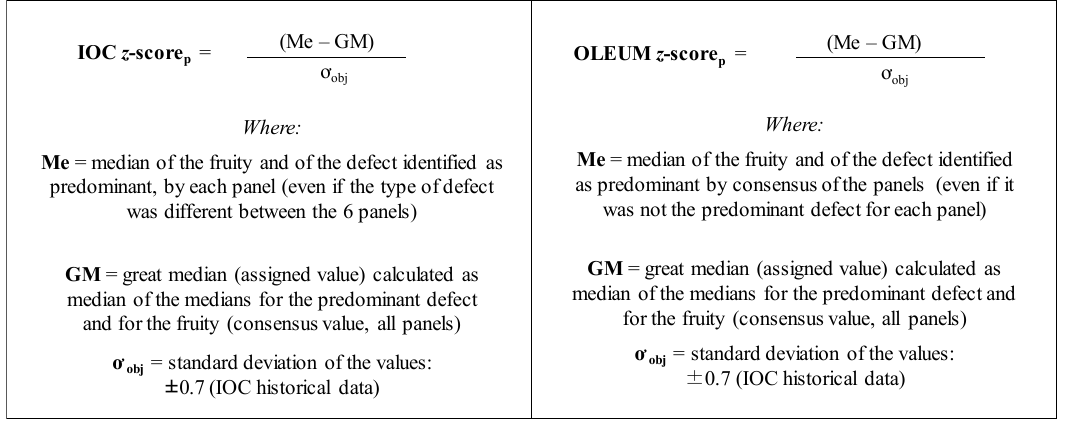
Figure 3. Formulas of the two methods used to calculate the z-score (IOC and OLEUM).